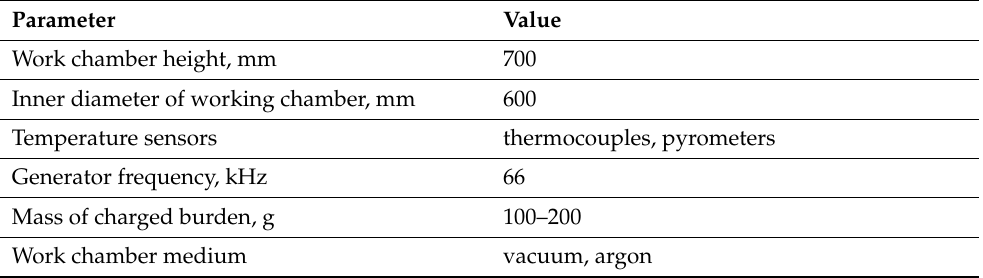
Table 2. Technical characteristics of the “VCG-135” test bench.